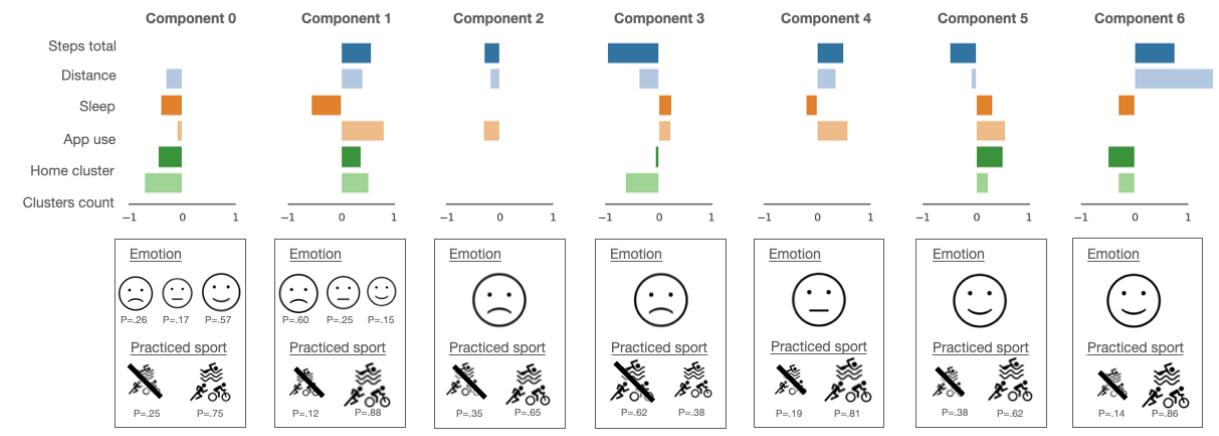
Figure 2. The 7-component mixture model structure was used for emotional valence modeling with each Gaussian mean in each component and indicating discrete emission probabilities. The size of the icons indicates the magnitude of the discrete emission probabilities (emotion and sport). In terms of features, "steps total" refers to step count, "distance" refers to the distance traveled, "sleep" refers to the hours of sleep, "app use" refers to the hours spent using different apps, "home cluster" refers to the time spent at home, "clusters count" refers to the number of visited locations, and "practiced sport" is an indicator of whether the patient practiced any sports. Of note, the negative mean values were a result of the normalization of the